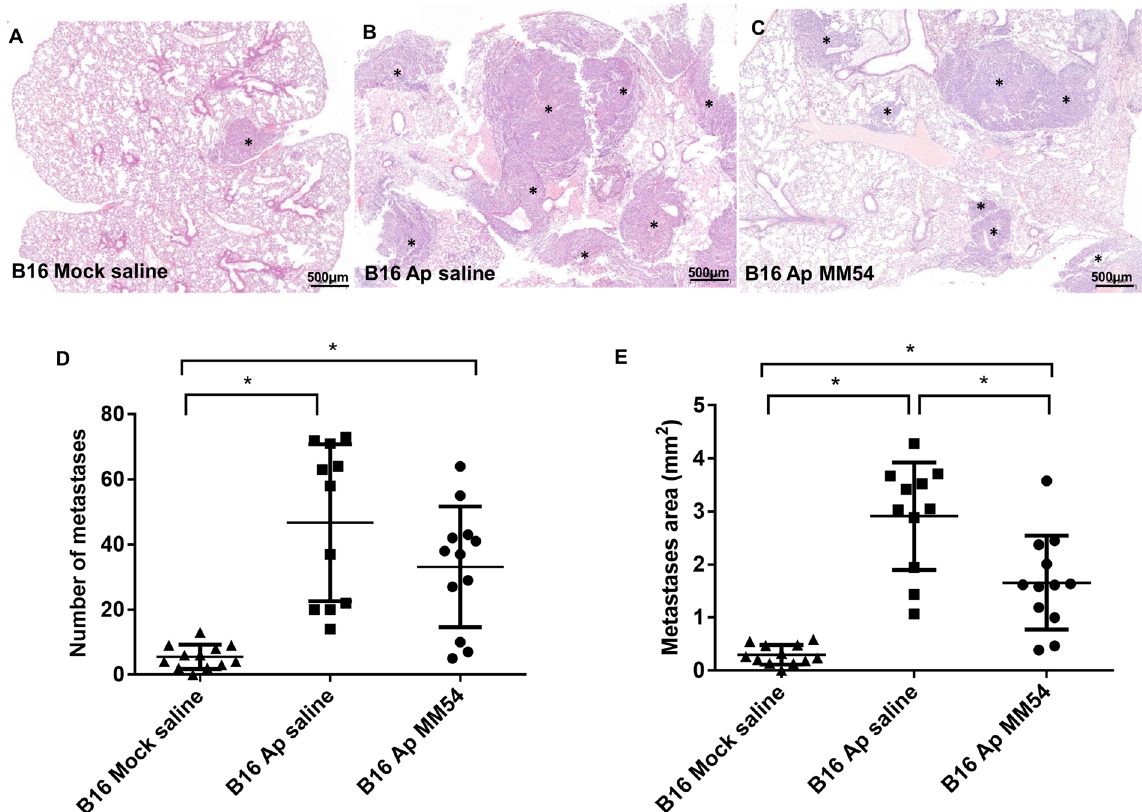
Figure 2. The effect of apelin overexpression and inhibition on the growth of experimental lung metastases. ( A – C ) Histological demonstration of lung metastases formed in the B16 Mock saline ( A ), B16 Ap saline ( B ) and B16 Ap MM54 ( C ) groups. Asterisks show the colony of the B16 Mock ( A ) or B16 Ap ( B , C ) melanoma cells in the lung. ( D , E ) Apelin overexpression significantly enhanced the number ( D ) and area ( E ) of B16 Ap lung metastases compared to the metastases of B16 Mock cells. Furthermore, the APJ antagonist MM54 had no impact on the number of metastases ( D ), but it significantly decreased the area of lung metastases formed by B16 Ap cells (E). * p <